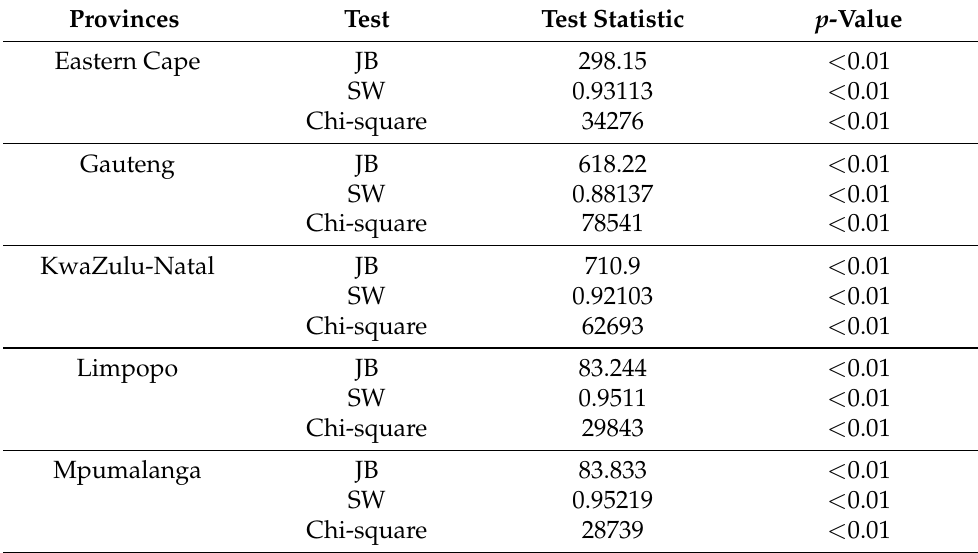
Table 3. JB, SW and chi-square normality test results of monthly rainfall data.